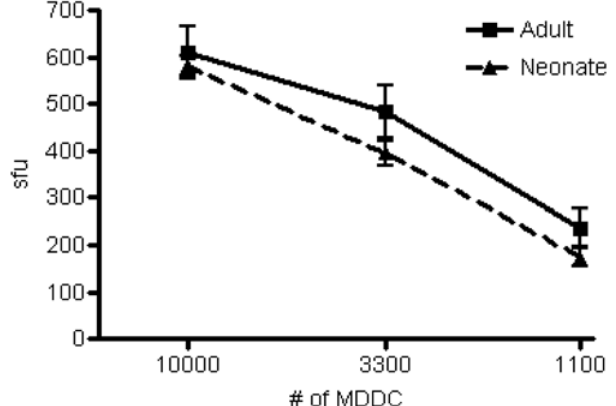
Figure 1. Equivalent peptide presentation of the HCMV pp65 nonamer NLVPMVATV by DC from adult and neonatal blood to HLA-A2- restricted clone CD8 + T cell clone D2-1-D2. The peptide NLVPMVATV was added in 10-fold dilutions (final concentration 10,000 pg/ml to 10 pg/ml) to HLA-A2 + monocyte-derived DC (20,000 cells/well) from adult ( n= 4) and neonatal ( n= 7) blood and incubated overnight with D2-1-D2 CD8 + T cell clones (10,000 cells/well). IFN- c production was detected by ELISPOT. Linear regression analysis was used to determine that there was no statistically significant difference between adult and neonatal DC in presentation of peptide to HLA-2- restricted CD8 + T cells (p=0.9882). Monocyte-derived DC (MDDC) were used as antigen presenting cells in all experiments and were derived as described in materials and methods.